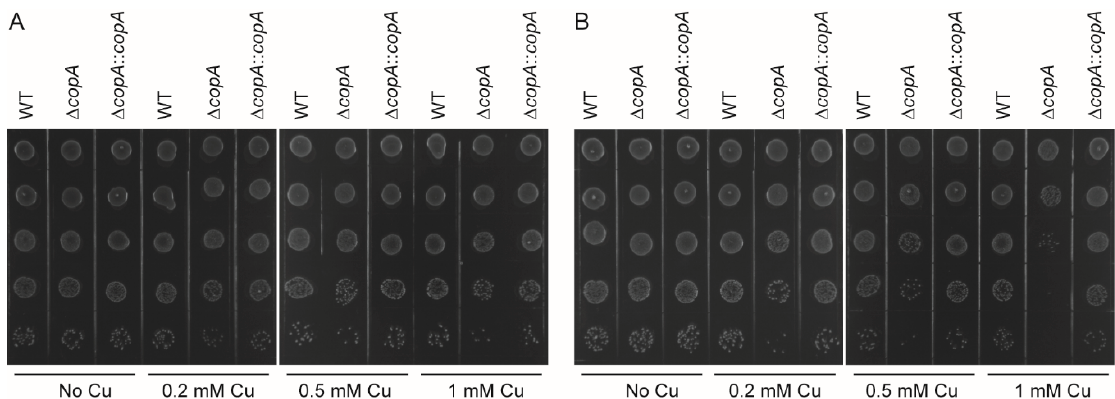
Figure 5. CopA is involved in S. suis resistance to copper toxicity in agar plates. Spot dilution assays of the WT, ∆ copA , and ∆ copA :: copA strains in the absence ( A ) and presence of 0.1 mM ( B ), 0.2 mM ( C ), and 0.5 mM ( D ) Cu. Overnight cultures of the strains were serially diluted, and 5 µ L of each dilution was spotted onto the plates from 10 − 1 (top) to 10 − 5 (bottom). The graphs are representative of three independent experiments.